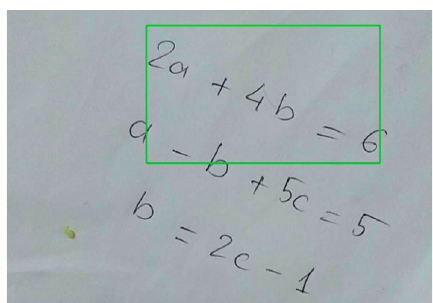
Figure 7: Equation area